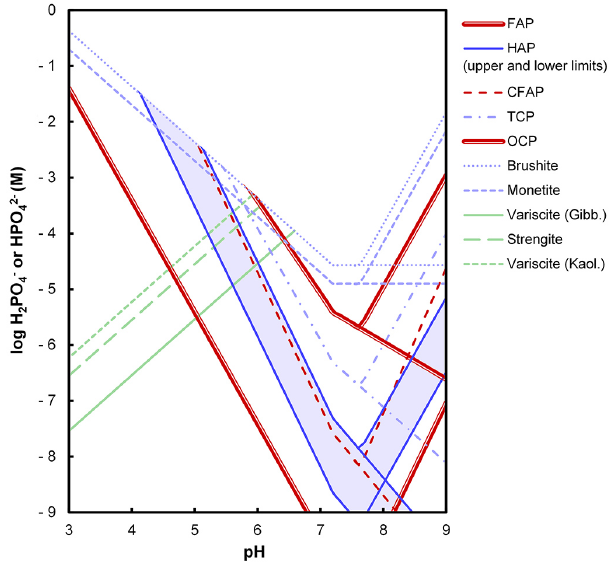
Figure 1. Apparent solubilities of calcium phosphates, strengite and variscite (in equilibrium with gibbsite or kaolinite) when Ca 2 + is 10 − 2 M or is fixed by calcite. CO 2 (g): 0.0003atm; F − : 10 − 4 M (equilibrium level of CaF 2 ) ; CO 2 − at the given CO 2 (g). Stren- 3 gite and variscite are more insoluble under acidic conditions while calcium phosphate solubility decreases with increasing pH. At pH > 7.88 calcium phosphate solubility may increase due to Ca 2 + depression caused by decreasing calcite solubility (see dividing curves at this pH for Ca 2 + depression or maintained Ca 2 + concen- tration). Calculations used apparent dissociation constants and ther- modynamic solubility products reported in Lindsay et al. (1989). To exemplify the inherent uncertainties arising from variability among Ksp measurements, hydroxylapatite (HAP) solubility was calcu- lated using the range of corresponding Ksp values reported in the literature (Baker et al., 1998). The solubility of carbonate fluorap- atite (CFAP) was calculated using the apparent Ksp of 10 − 103 given by Perrone et al. (2002). See Lindsay et al. (1989) for details on calculations. Results for this system are similar to those computed by more-sophisticated algorithms (e.g. MEDUSA; Puigdomenech, 2000). See Atlas (1975) for the theoretical dependence of calcium phosphate solubility on salinity. FAP: fluorapatite; TCP: tricalcium phosphate; OCP: octacalcium